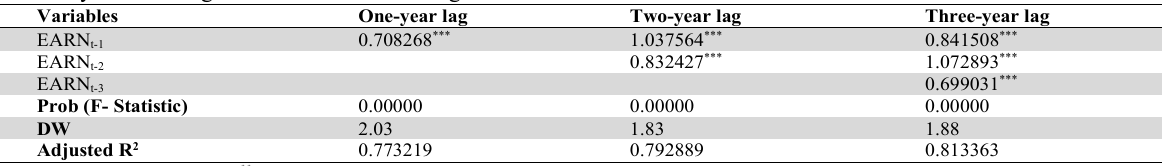
Summary of FEM regression results of earnings model